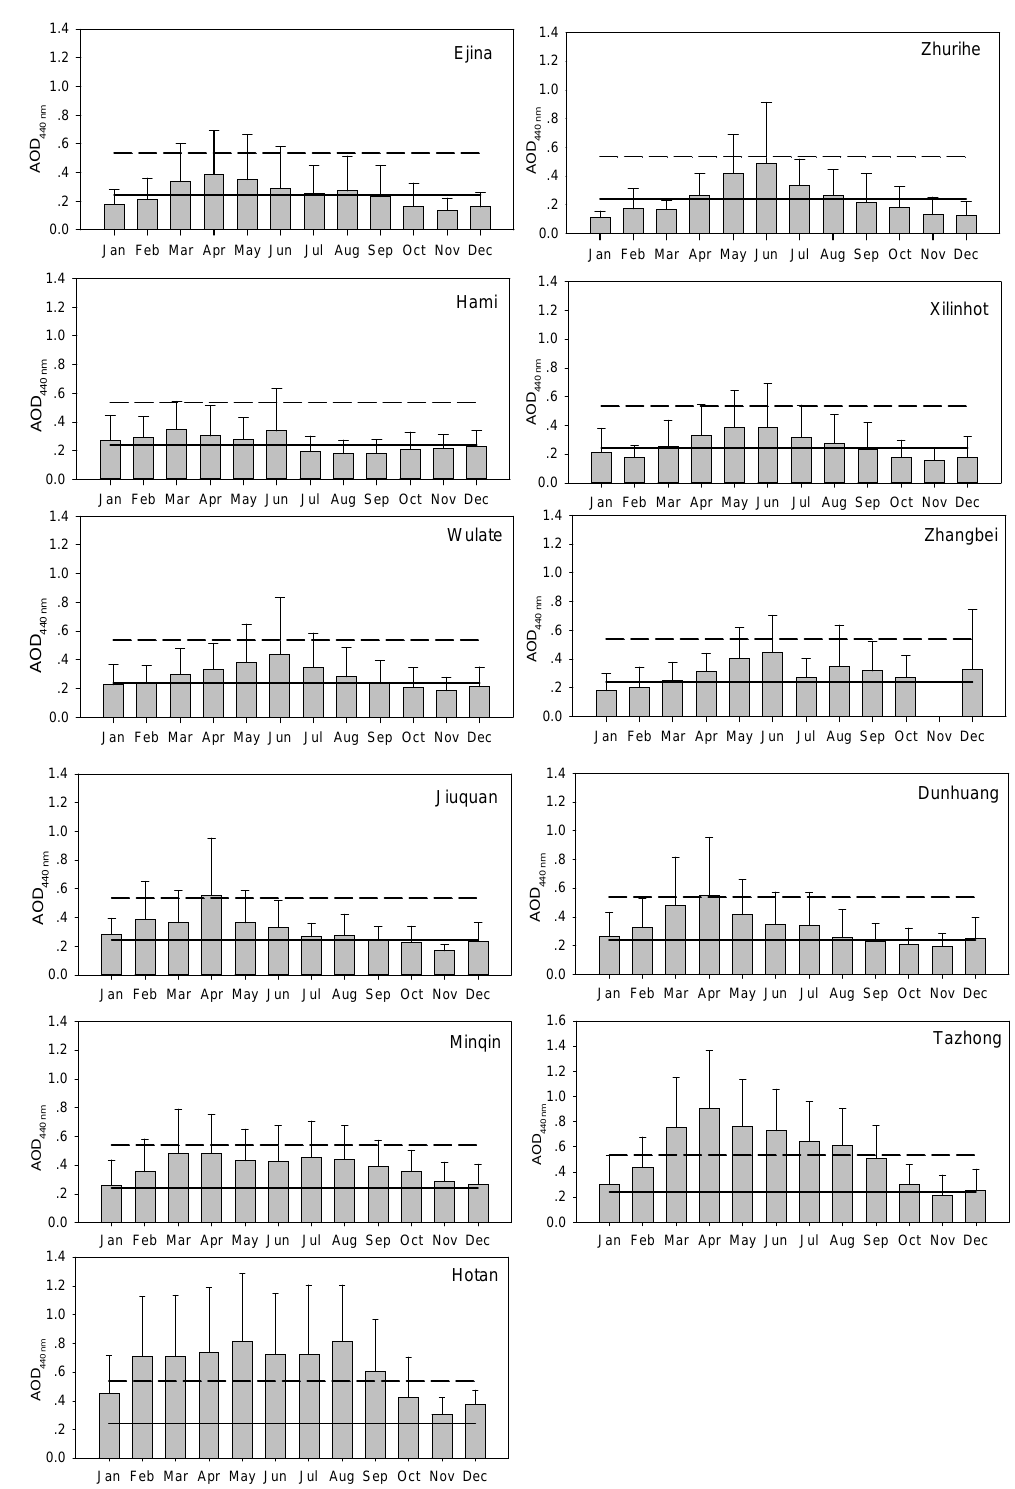
Figure 8. Monthly averaged AODs at 440nm at rural desert sites. The solid and dash horizontal hairlines indicate the annual averages for the subgroup and the whole database,